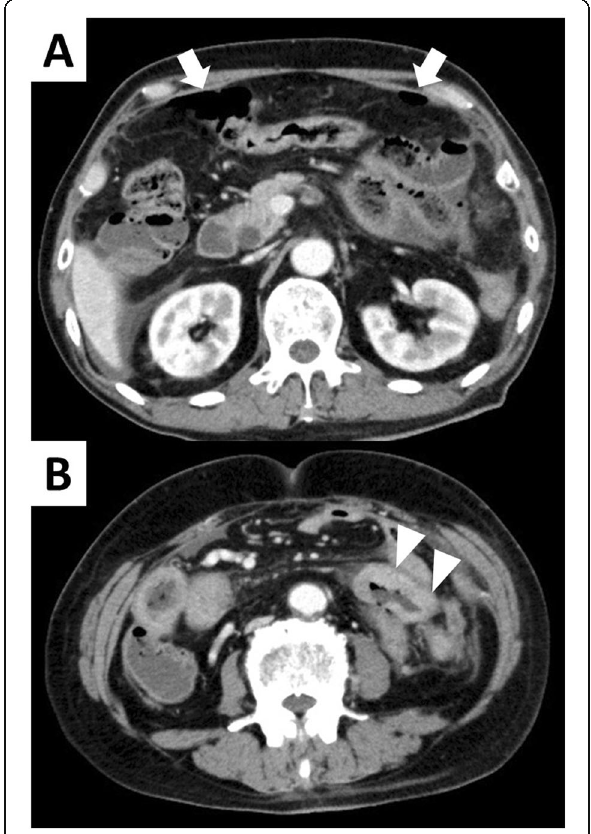
Fig. 1 a , b Abdominal enhanced CT pictures are shown. Arrows show abdominal free air, and triangles show the perforation site of small intestinal metastasis of lung adenocarcinoma